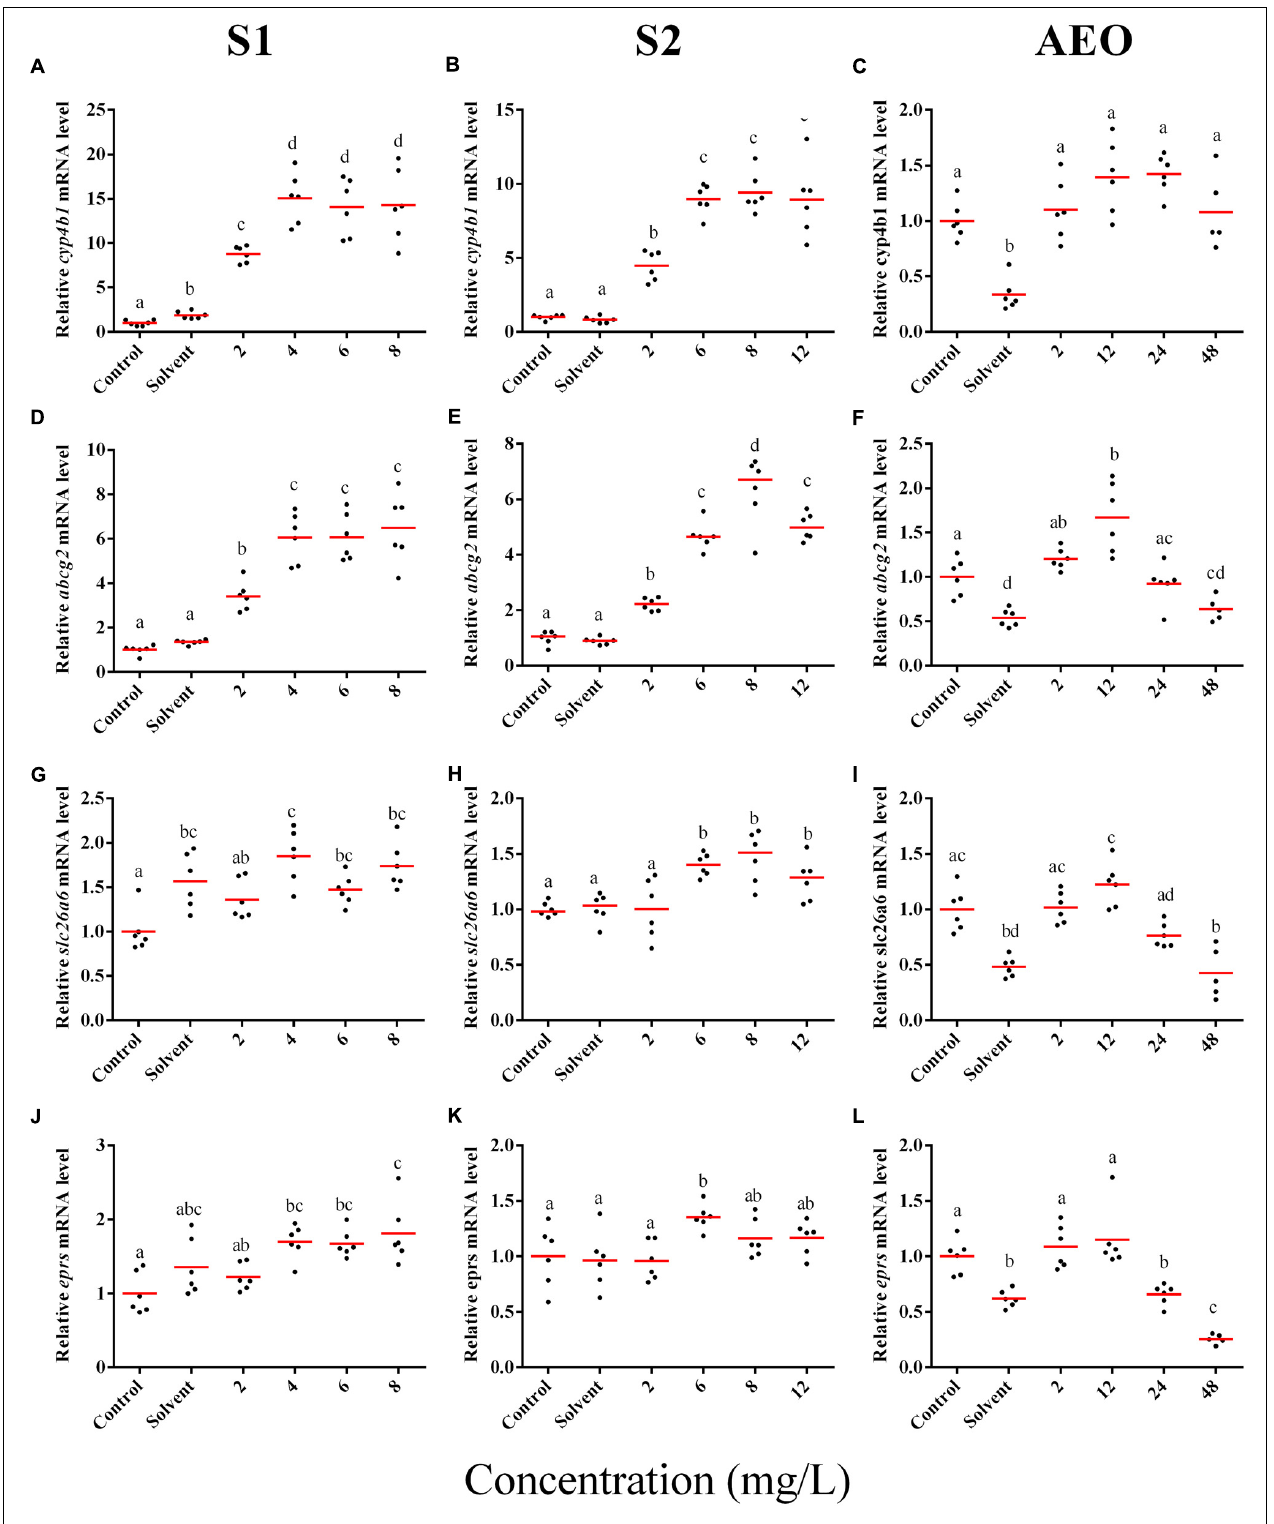
FIGURE 5 | RT-qPCR analysis for cyp4b1 (A–C) , abcg2 (D–F) , slc26a6 (G–I) , and eprs (J–L) , mRNA in S. tropicalis exposed to different concentrations of S1 (first column), S2 (second column), and AEOs (third column). Data were normalized and defined as fold change relative to control. Different letters indicate groups that are significantly different ( p <